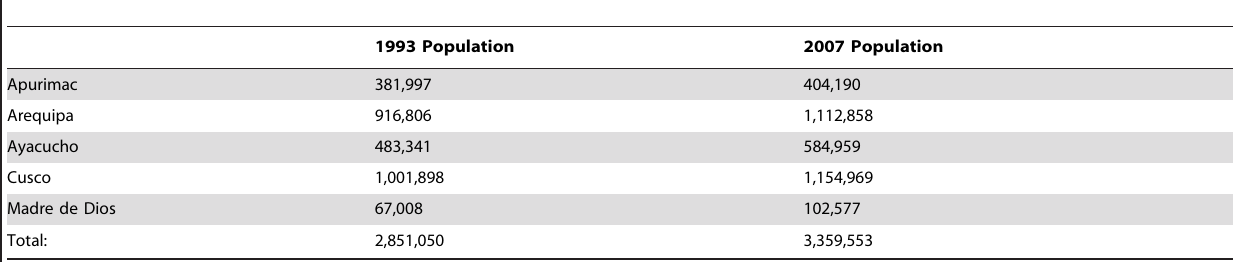
Table 2. Population counts for the five regions included in the